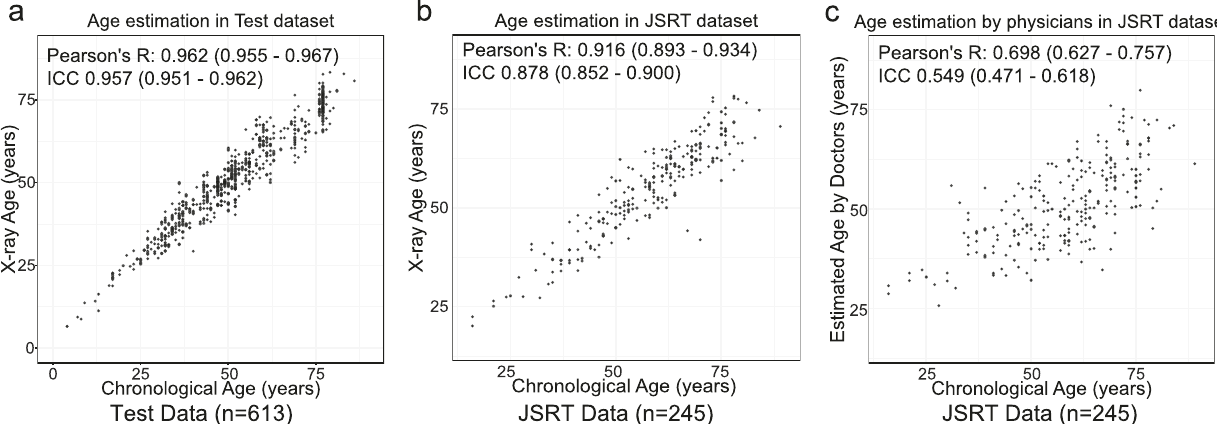
Fig. 2 Estimation accuracy of the deep learning model and human physicians. Estimated age by the trained deep learning model (X-ray age) in the test dataset ( n = 613) ( a ), JSRT dataset ( n = 245) ( b ), and estimated age by human physicians and radiologists in the JSRT dataset ( n = 245) ( c ). Scatter plots of the chronological age (x-axis) and estimated age (y-axis) with Pearson ’ s correlation coef fi cient and intraclass correlation coef fi cient case 1 (ICC) and 95% con fi dence interval are shown. A strong positive correlation between the chronological and estimated ages was observed in the deep learning model. For the human estimation, the estimated age is the average of the estimations by the four physicians and three radiologists. The correlation between the chronological and estimated ages is modest ( c